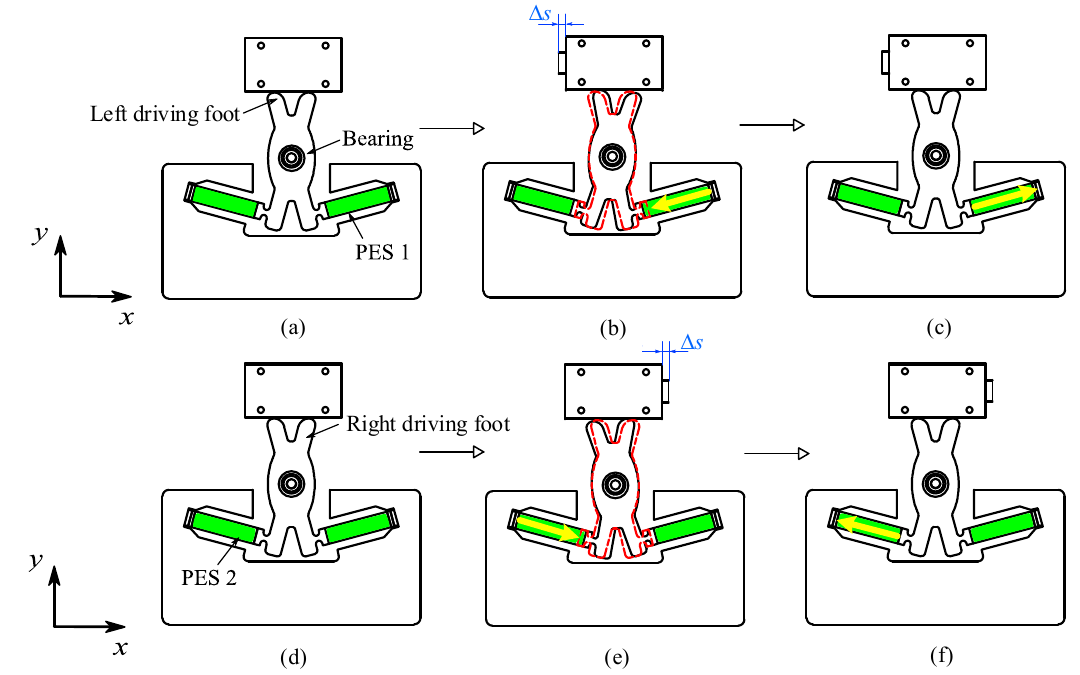
Figure 3. Motion principle of the actuator. Figure 3a–c illustrate the motion processes along the positive x -axis (forward motion), and Figure 3d–f illustrate the motion processes along the negative x -axis (reverse motion).